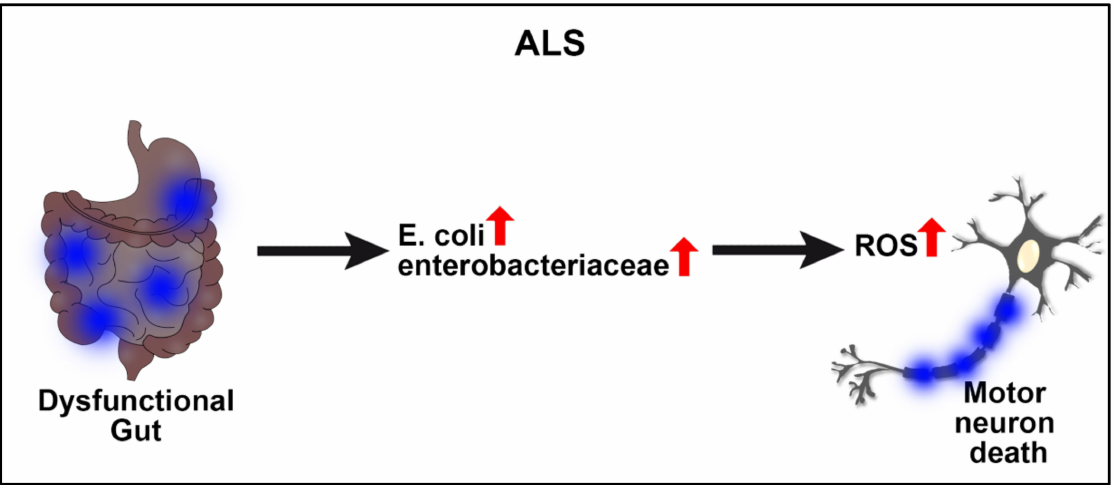
Figure 1. ALS and GBA. A dysfunctional gut accompanies the progression of ALS, with increased bacteria, including E. coli and enterobacteriaceae, leading to upregulation of damaging reactive oxygen species (ROS) and eventually contributing to motor neuron death, which is a hallmark pathological manifestation of the